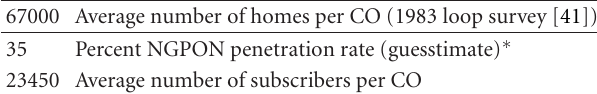
Table 3: Simulated serving area sizes for P2P results.